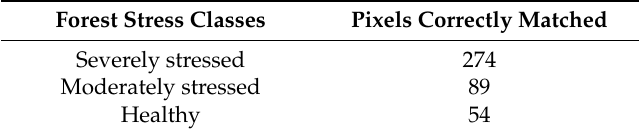
Figure 8. The map showing the distribution of Norway spruce stands under different stress levels in the Bavarian Forest National Park, July 2016. The map was produced using canopy surface temperature and measured leaf traits (foliar stomatal conductance, chlorophyll fluorescence, and water content).